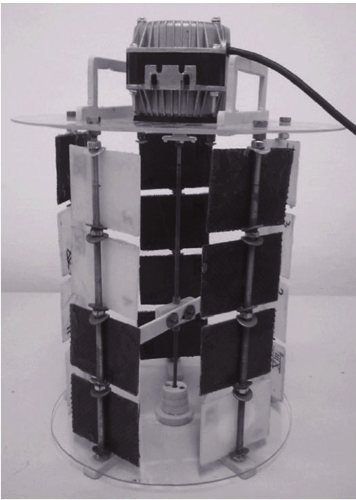
Figure 6: Stand for sea water tests.